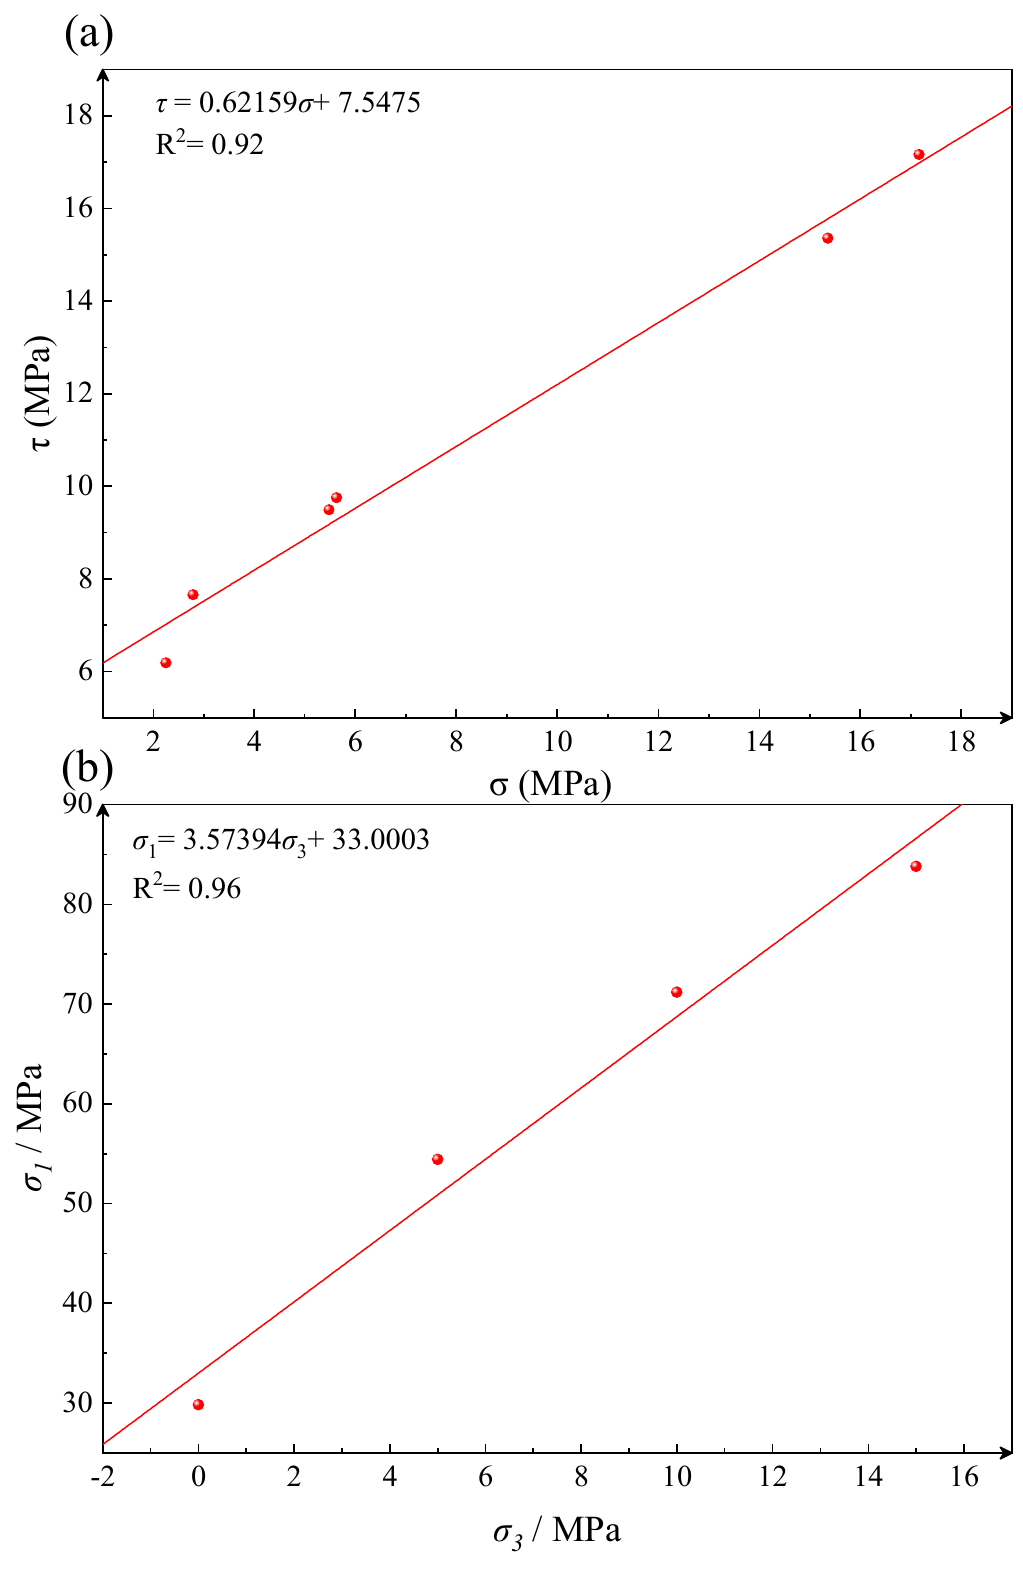
Figure 6. Fitted curves for indoor test: ( a ) compression shear test ( b ) conventional triaxial